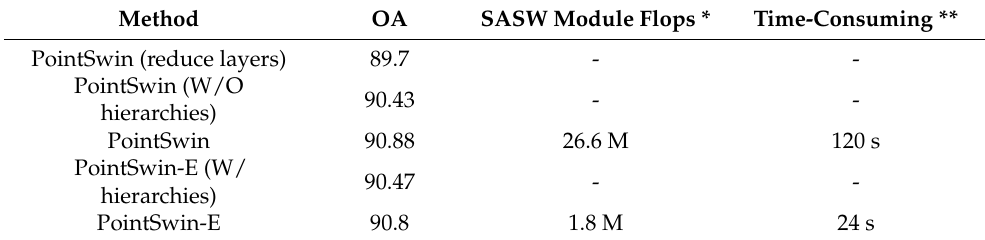
Table 5. The OA and flops results of group 3.